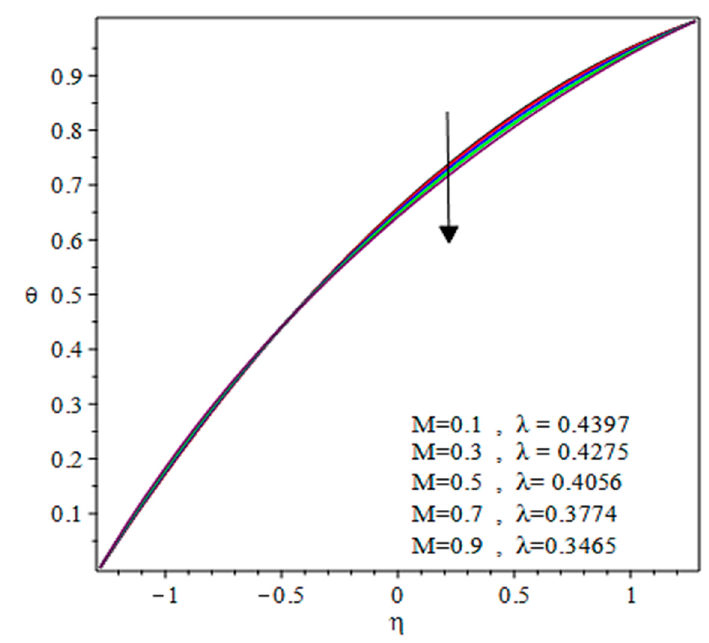
Figure 22. Influence of M on the temperature distribution at ξ = 0.75.